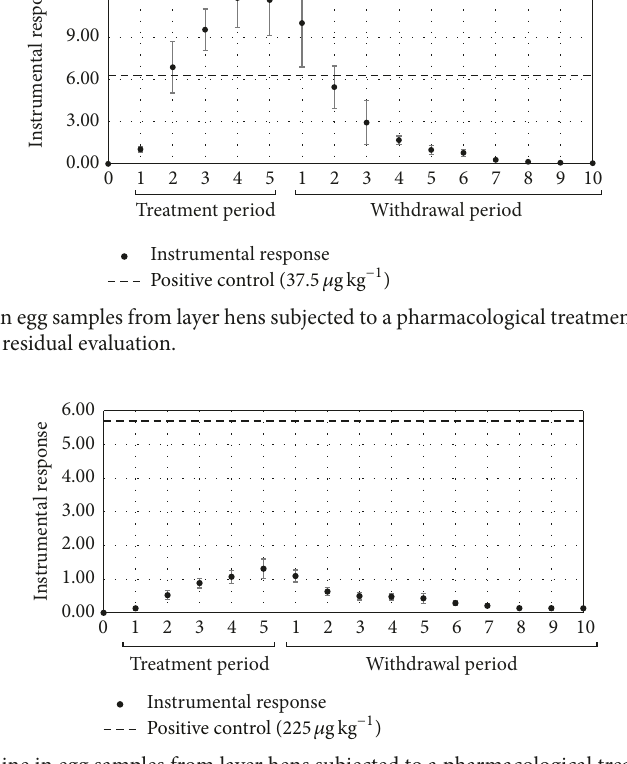
Figure 4: Residues of oxytetracycline in egg samples from layer hens subjected to a pharmacological treatment with oxytetracycline during the drug administration period and days of residual